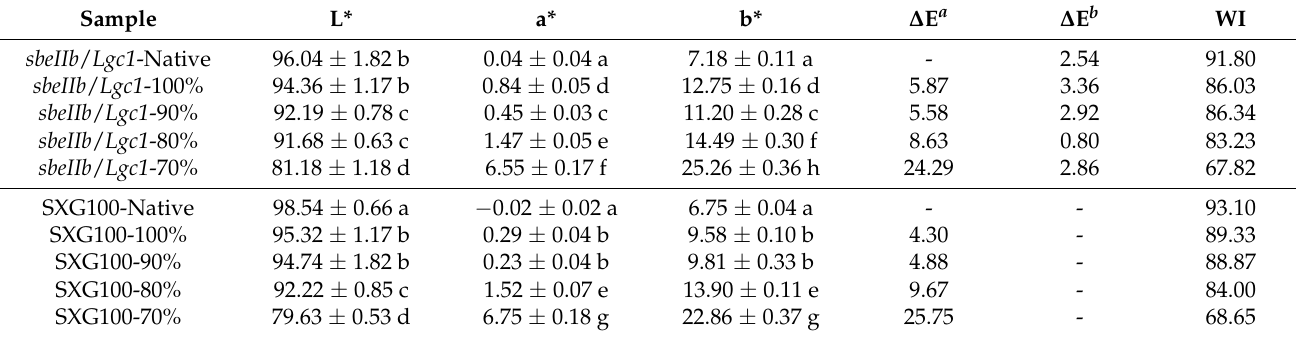
Figure 2. The appearances of native and HMT flours of sbeIIb / Lgc1 and SXG100 rice. N represents native flour. The numbers on the upper part of the figure represent the rice flour mass fraction (%) of samples subjected to HMT. Table 2. The chromaticity of native and HMT rice flours of sbeIIb / Lgc1 and